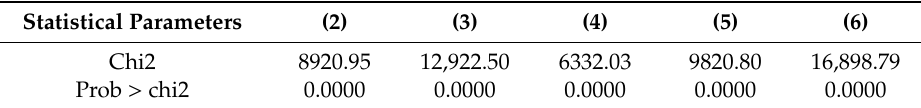
Table A4. Wald test of constant variance.